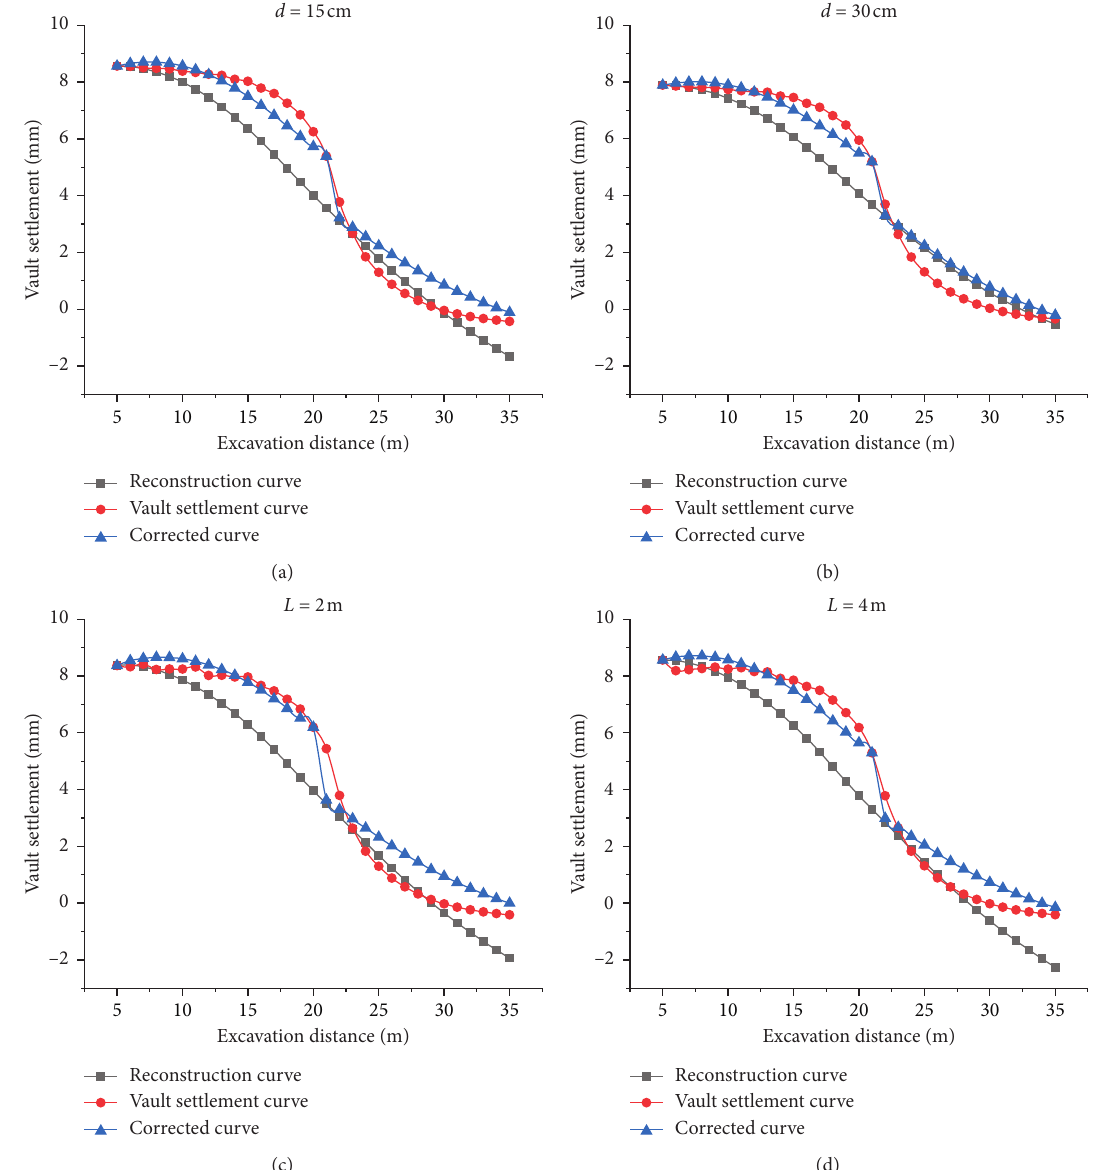
Figure 7: Deformation reconstruction under the influence of support